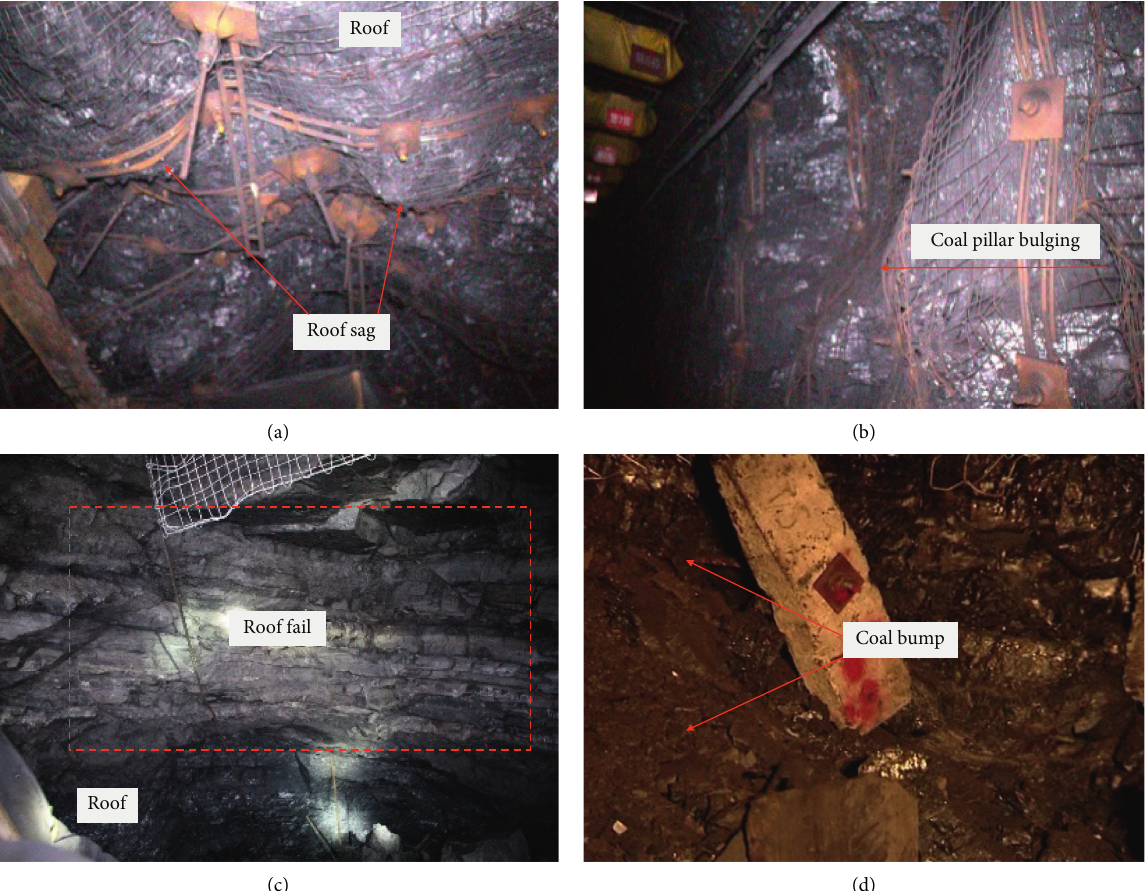
Figure 6: The deformation failure of the 8107 headgate. (a) Roof sag. (b) Coal pillar bulging. (c) Roof fail. (d) Coal